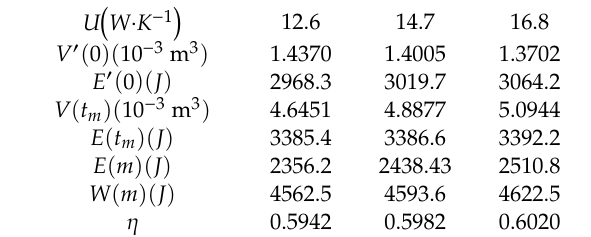
Table 1. Parameters versus U for the case of n = 1.